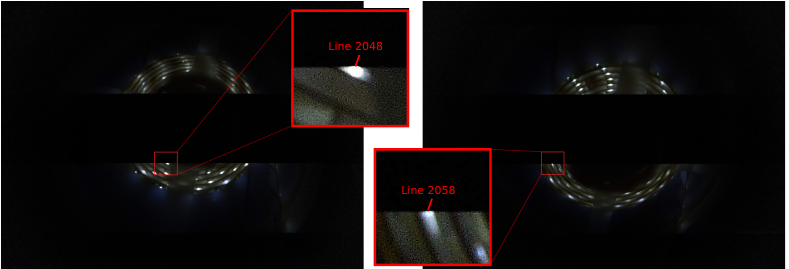
Figure 12. Light source real images obtained during the evaluation. This setup provides the estima- tion of the offset between two frames shot by different smartphone cameras. The cameras capture a flashing event. Obtained images may have different dark-to-bright edge positions (2048th and 2058th lines in this case). The cameras do not have to be aligned. This simplifies the estimation process compared to that in Reference